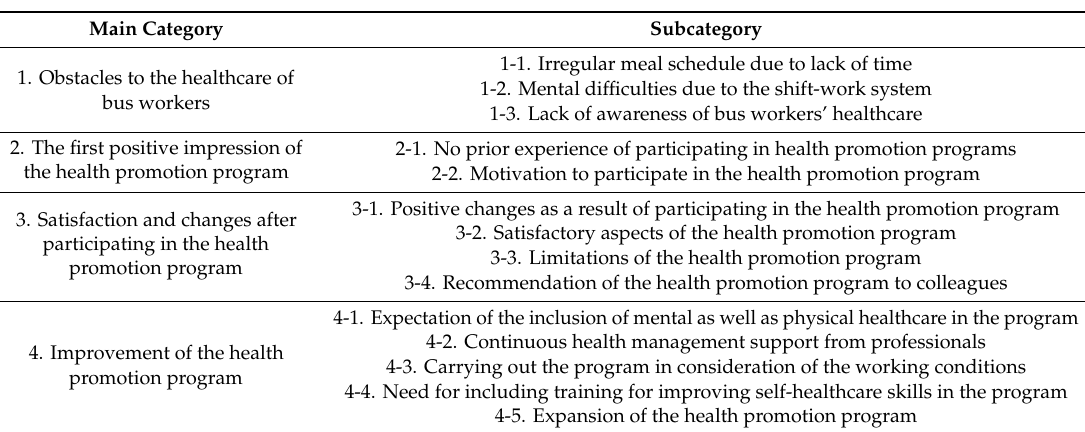
Table 2. Categorization